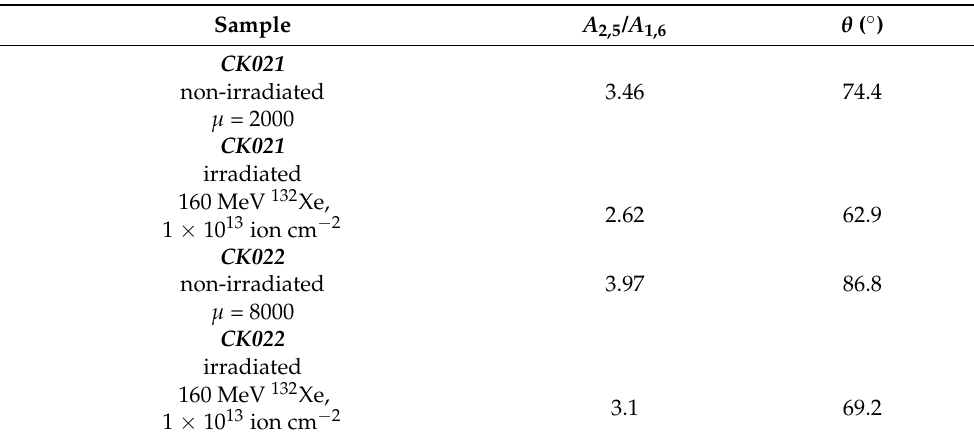
Table 3. Effect of swift heavy ion irradiation on the orientation of magnetization at the surface of differently stress-annealed FINEMET